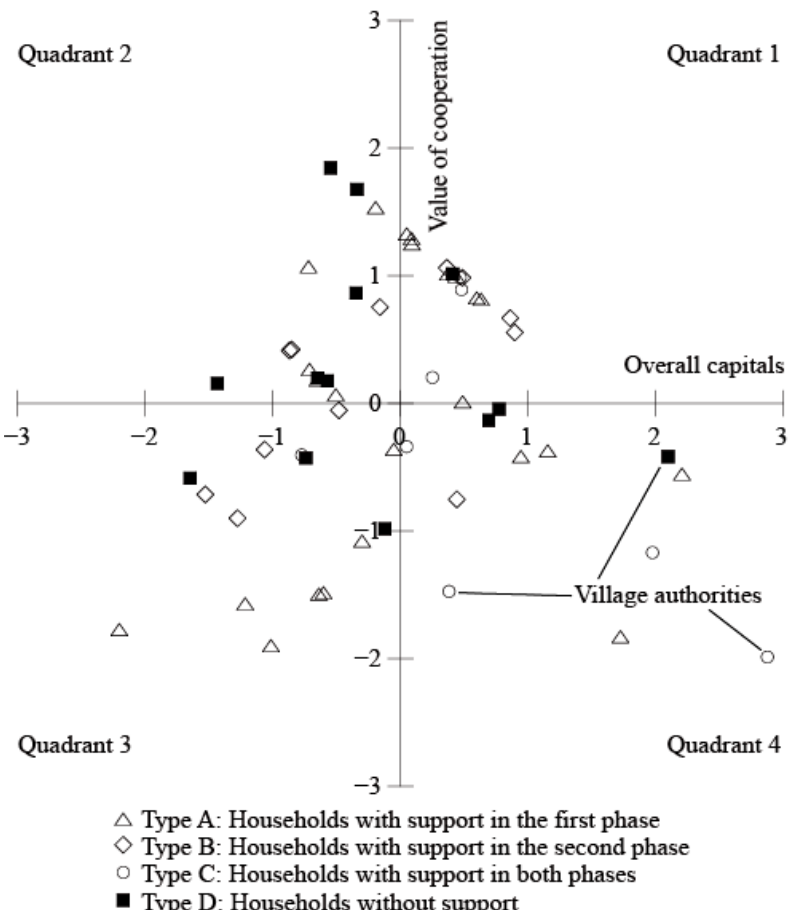
Figure 3. Distribution (factor scores) of surveyed households on two principal components (PCs) by support type. PC1 (asset) is used as the x-axis and PC2 (value of cooperation) is used as the y-axis. Note: three households plotted in Quadrant 4 were village authorities.